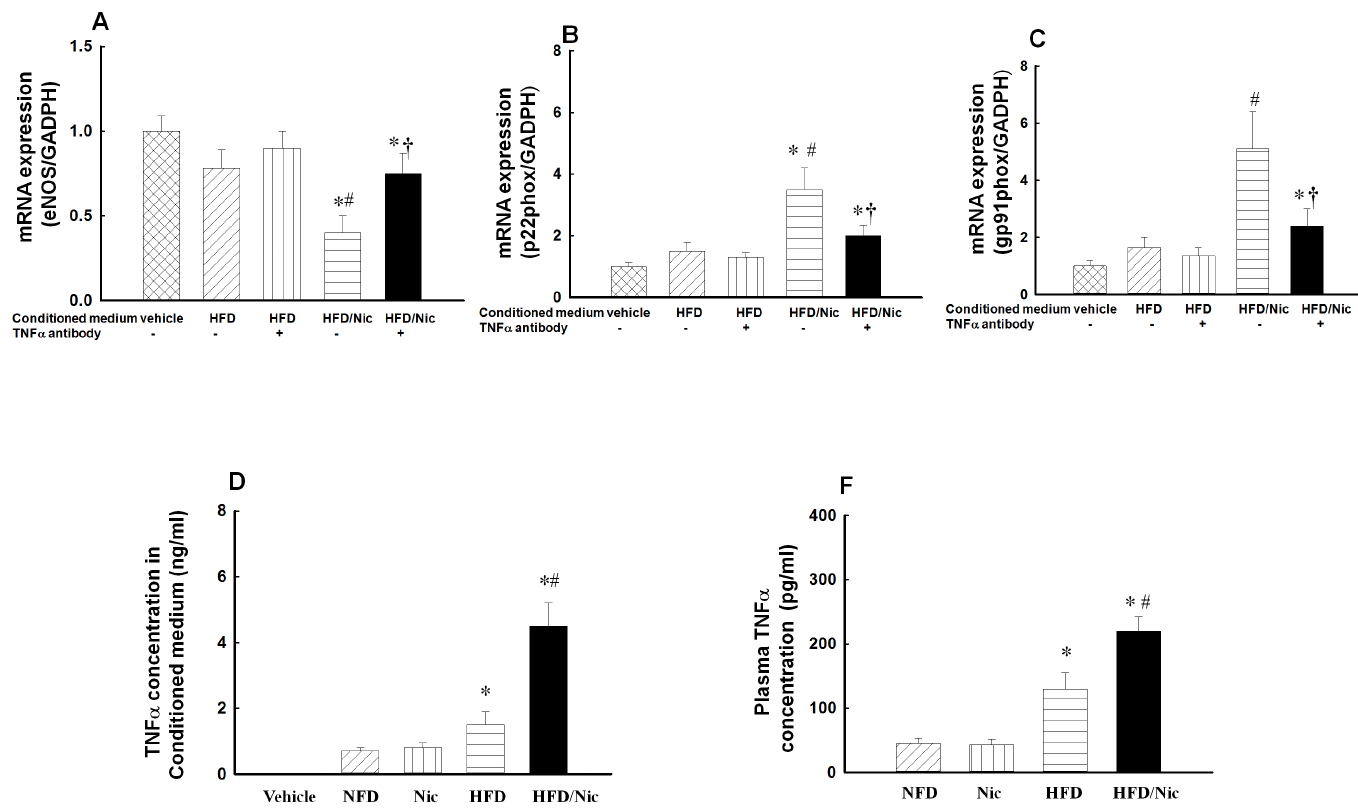
Fig 8. Effects of neutralizing TNF α antibody on the mRNA expressions of eNOS (A), gp91phox (B) and p22phox (C) in HUVECs. The conditioned medium was pre-incubated with neutralizingTNF α antibody for one hour to block TNF α effects, the medium then was added to HUVECs to incubate for another 24 hours, the mRNA expressions of eNOS, gp91phox and p22phoxin HUVECs were determined by real-time PCR. TNF α antibody in the conditioned medium from nicotine-obese rats partially restored the expressionof eNOS, gp91phox, p22phox. TNF α concentration in conditionedmedium (D) or in plasma (F) was increasedin obese(HFD) rats, and was further increasedin nicotine-obese rats. * p < 0.05vs. vehiclemedium; #p < 0.05vs. HFD; †p < 0.05vs. correspondence group without TNF α antibody.N = 5–6.